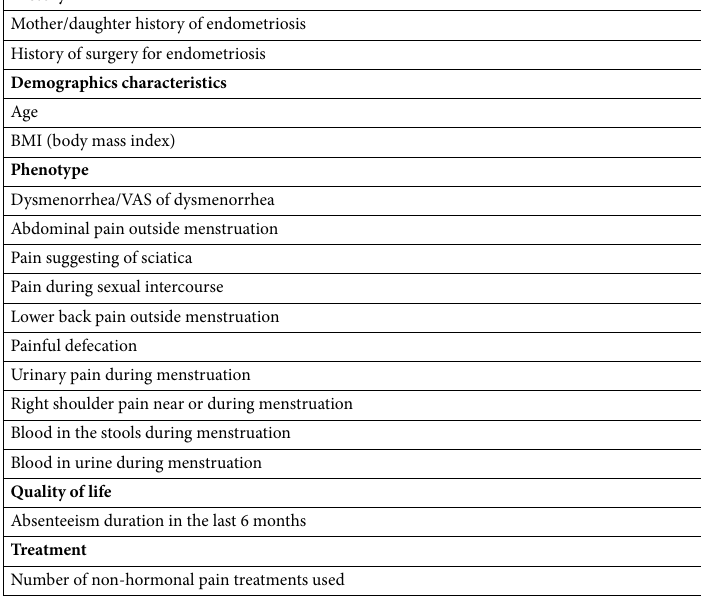
Table 3. A summary of the 16 dataset features considered in the training approach.